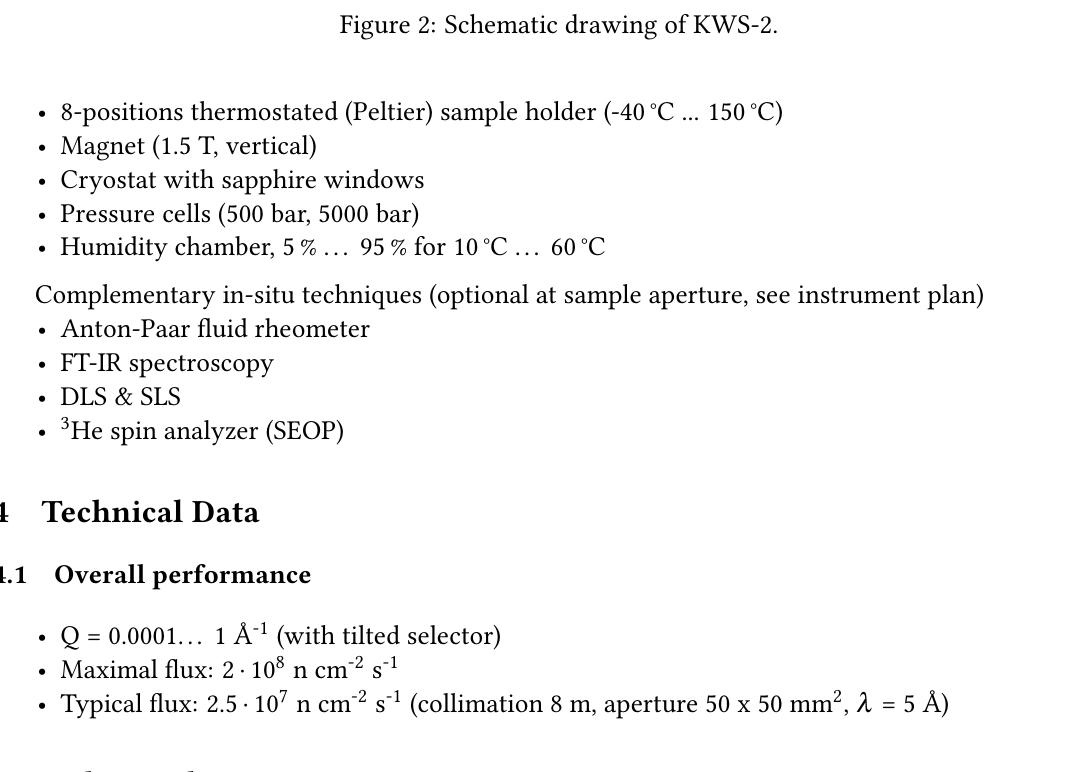
Figure 2: Schematic drawing of